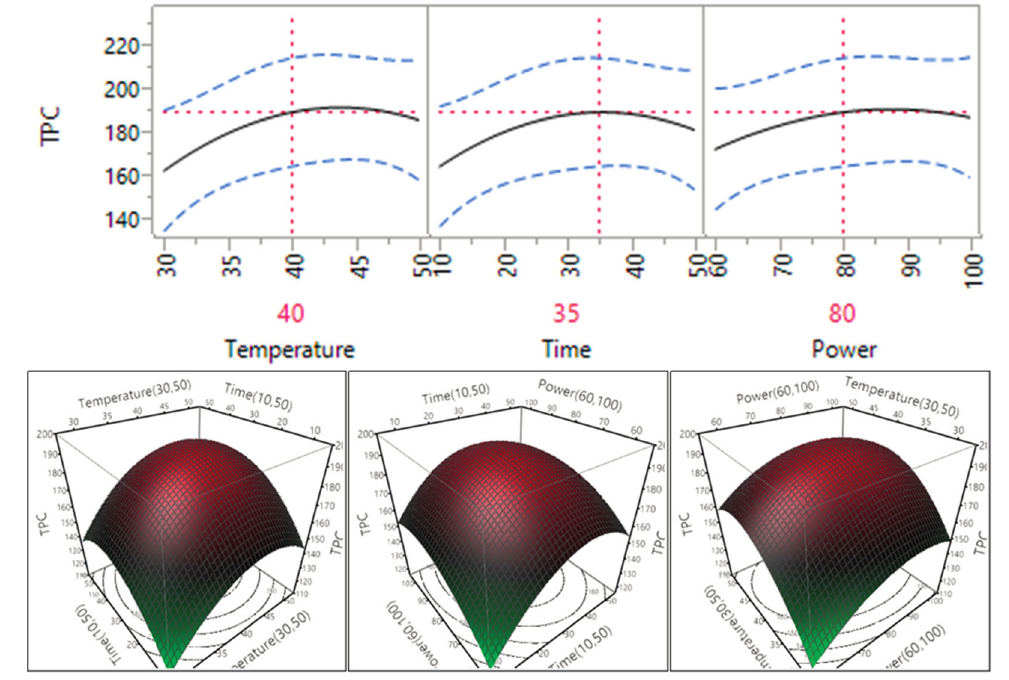
Figure 4. Impact of temperature (60–90 °C), time (10–30 min) and power (60%–100%) on TPC (mg GAE/g). Table 3. Analysis of variance for the experimental results on TPC, flavonoids and proanthocyanidins. Parameter